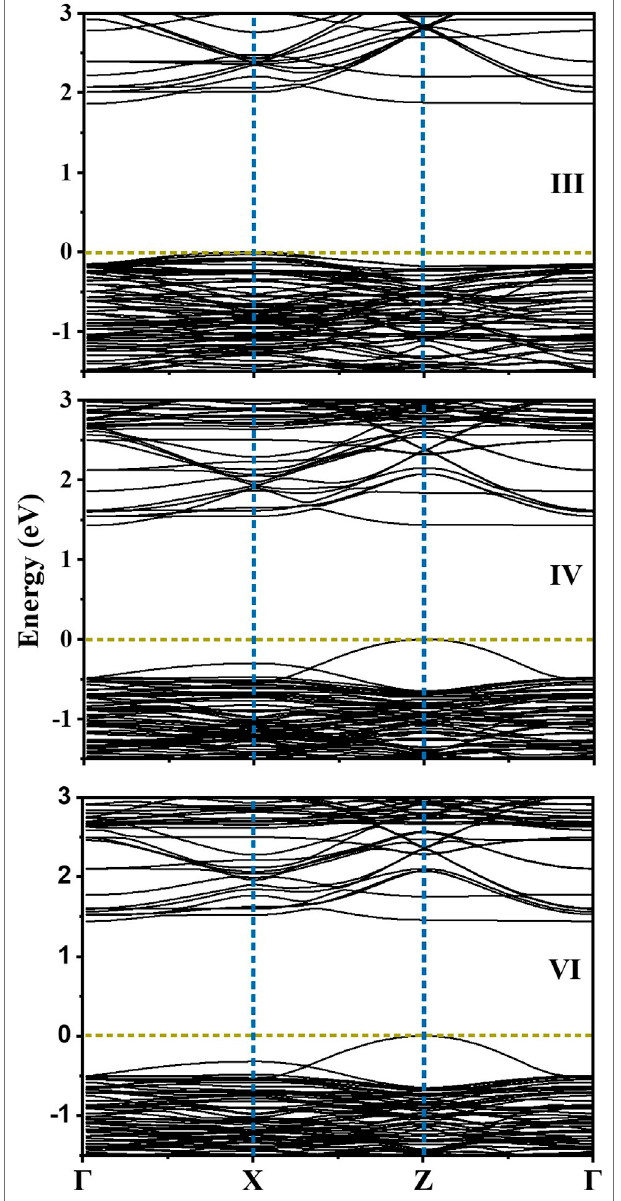
FIGURE 6 | Electronic band structure calculated for the con fi gurations III,IVandVIforBaTi 1-x (Cu 1/2 Te 1/2 ) x O 3 wherex (cid:2) 0.11alongthehighsymmetry k -points.